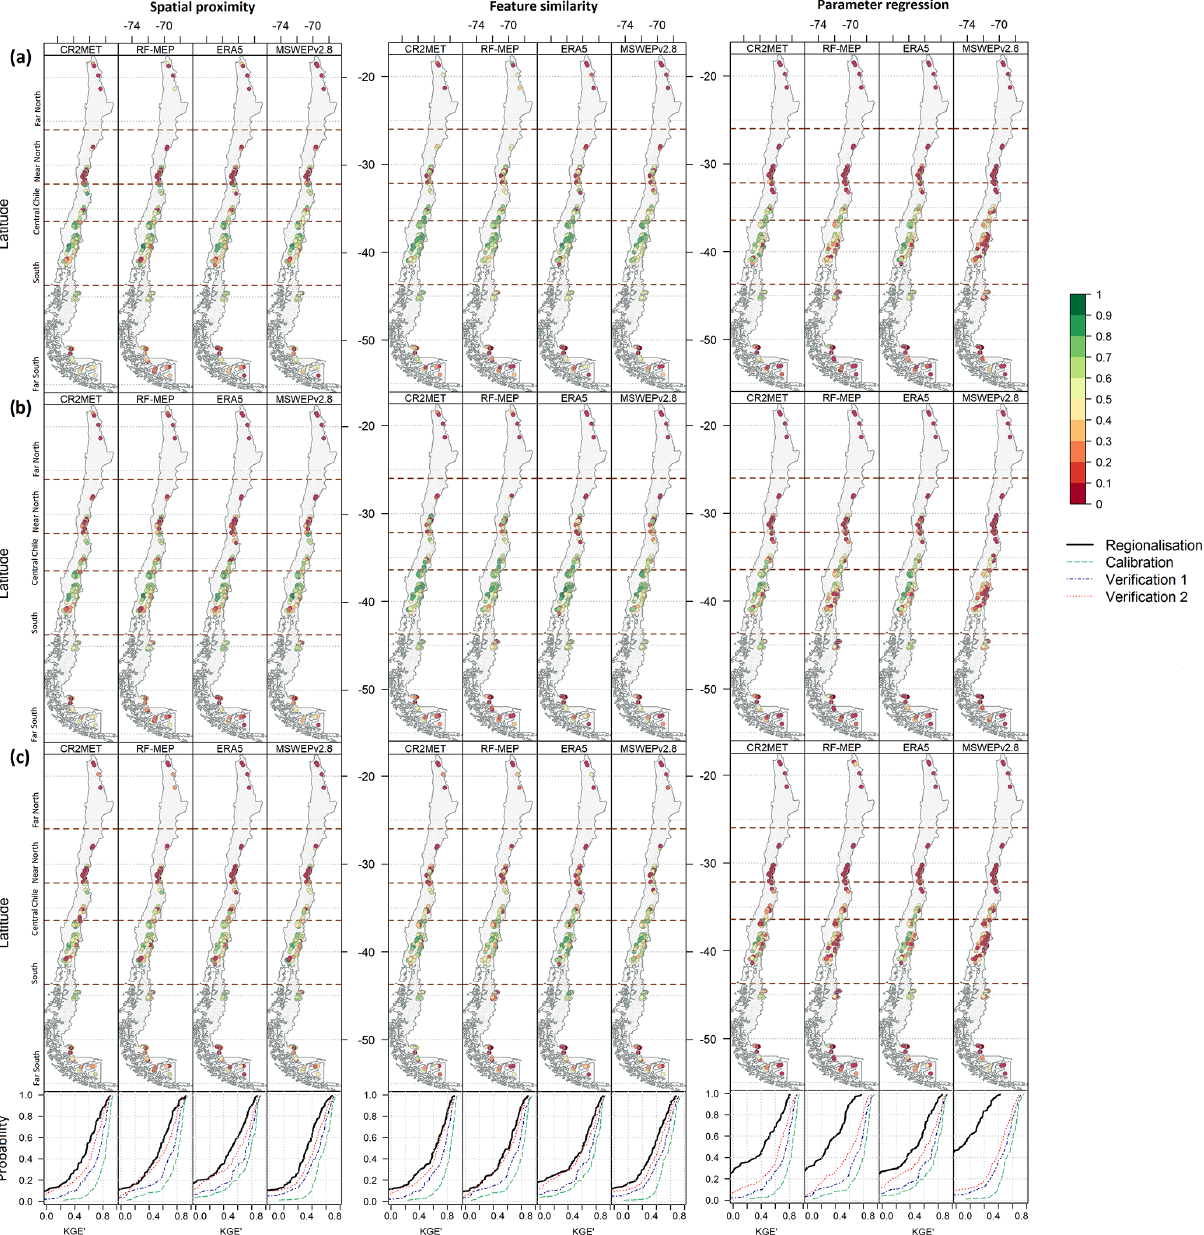
Figure 7. Spatial performance of the leave-one-out cross-validation results for the three regionalisation methods according to P products used to force TUWmodel. Results are presented for the (a) calibration (2000–2014), (b) Verification 1 (1990–1999), and (c) Verification 2 (2015–2018) periods. The panels beneath the map plots refer to the ECDFs of the corresponding regionalisation technique for the entire period of analysis (1990–2018) and P products (black) against the performances during the independent calibration (green), Verification 1 (blue), and Verification 2 (red)